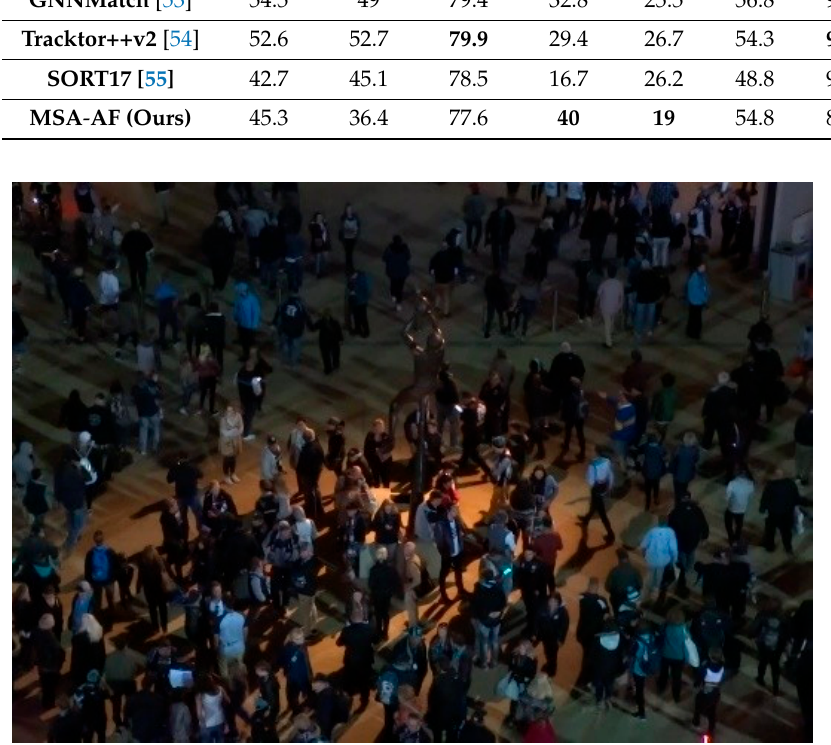
Figure 13. A sample from the MOT20-04 video